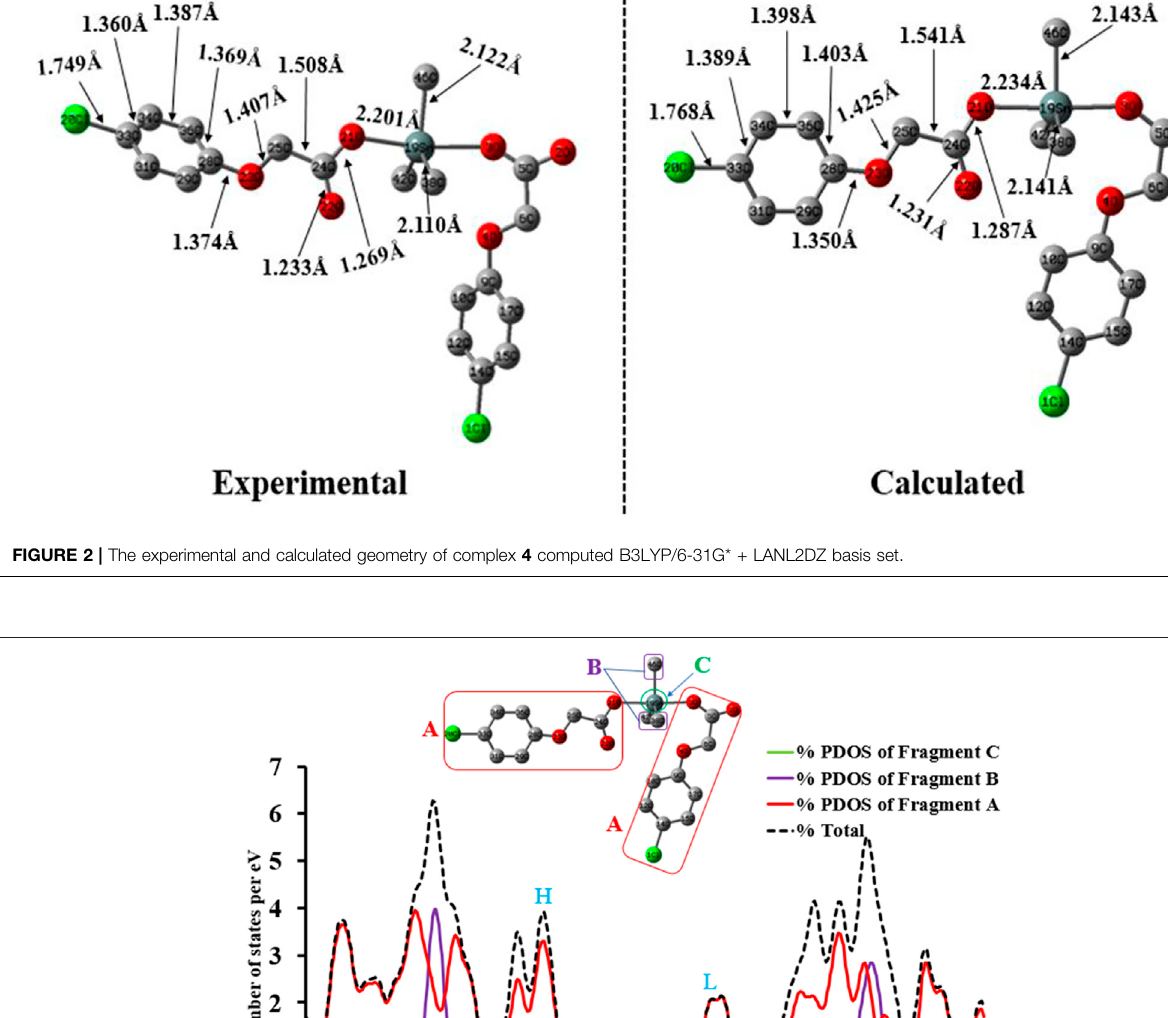
Frontiers in Pharmacology |